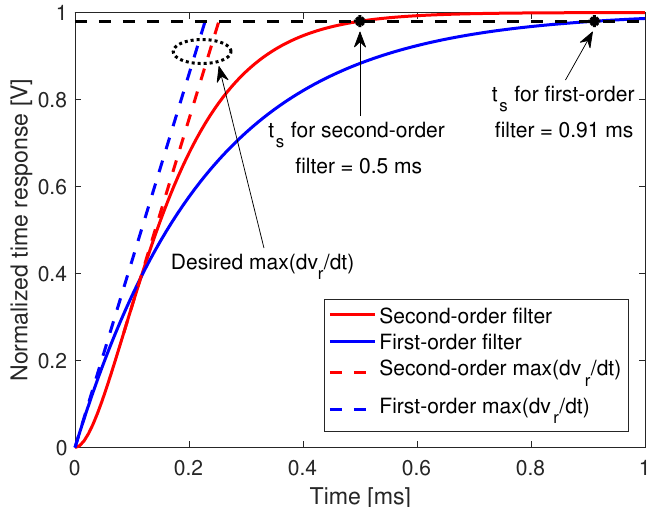
Figure 7. Normalized time response of first-order and second-order